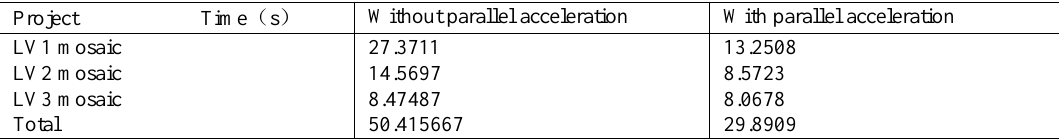
Table 2. Operation time